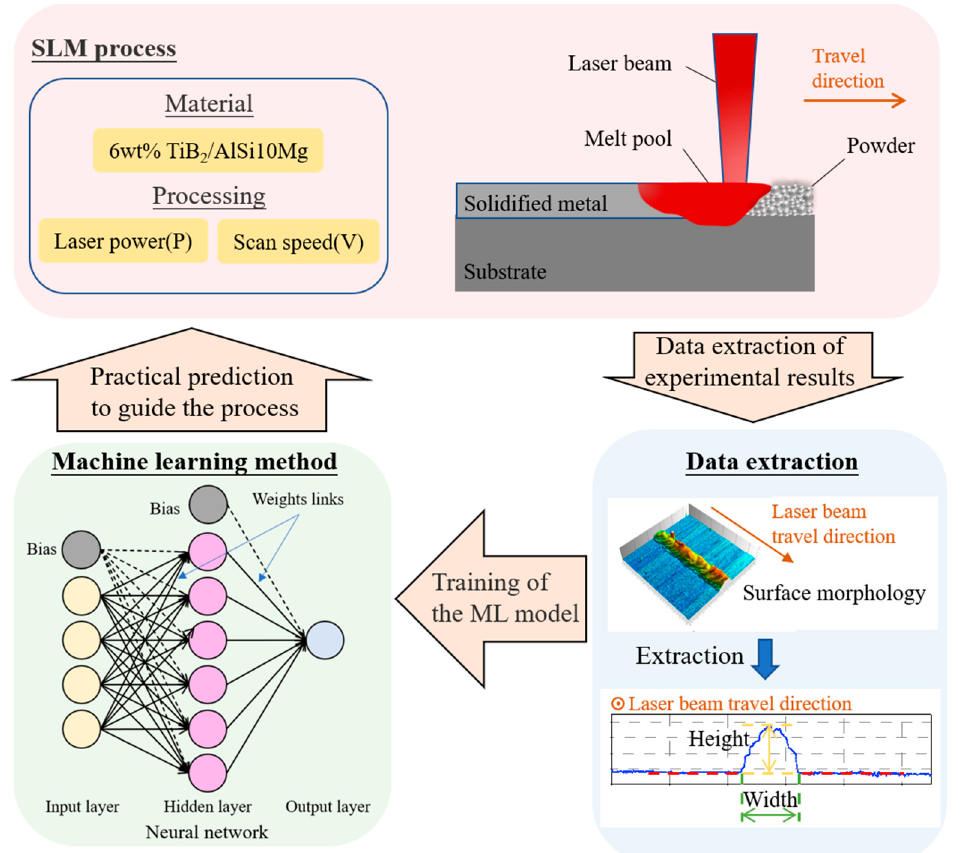
Figure 1. Schematic of the prediction method. The components are the SLM process, data extraction, and machine learning method. After extracted from the experimental results and calculated, the data set is used to train the machine learning model. The trained model can detect the defect track and predict the printability to guide the SLM process.